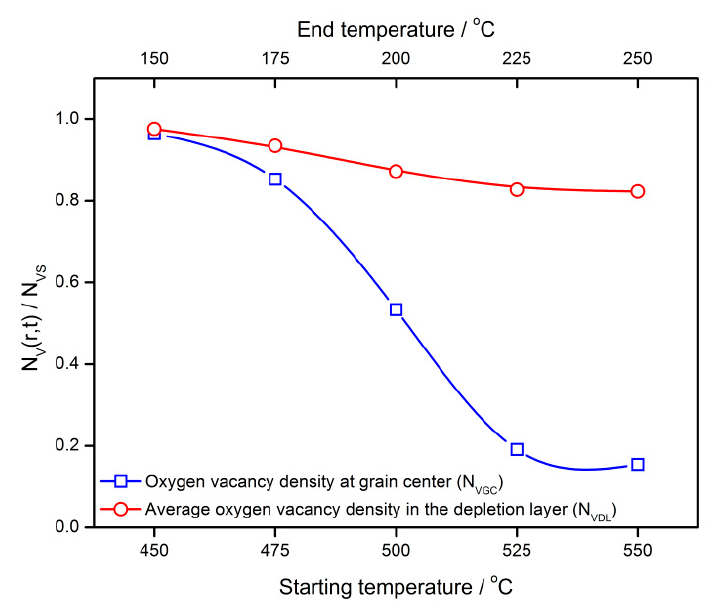
Figure 20. Influences of the temperature interval on the steady state oxygen vacancy density at the grain center ( N VGC ) and an average steady state oxygen vacancy density in the depletion layer ( N VDL ).